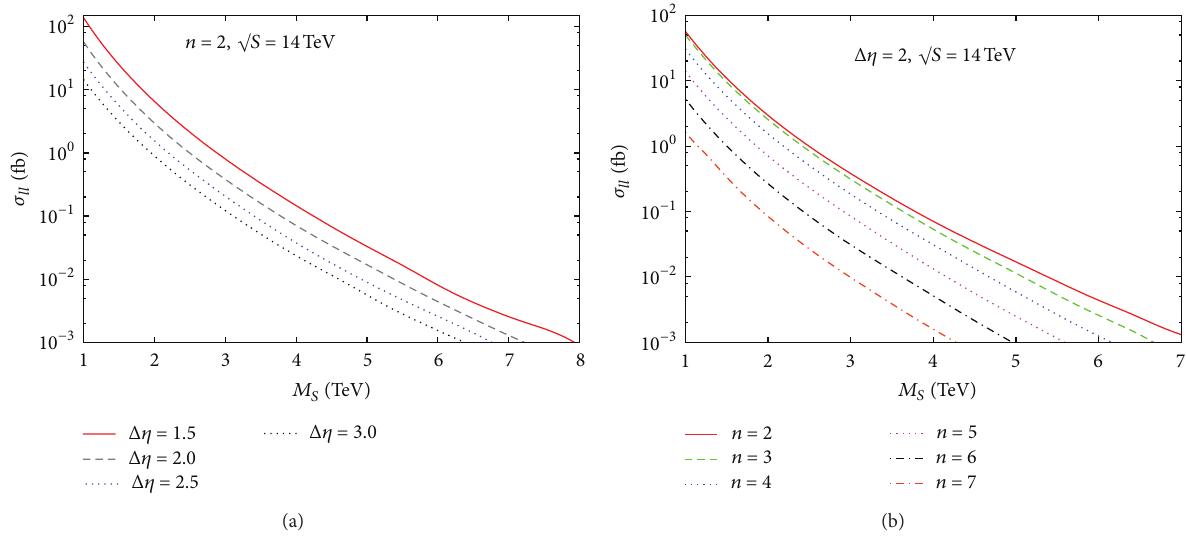
𝑛 = 2 – 7 for Δ𝜂 = 2 . In both plots, 𝜎 𝑙𝑙 for 𝑙𝑙 ’s are computed after applying the cut